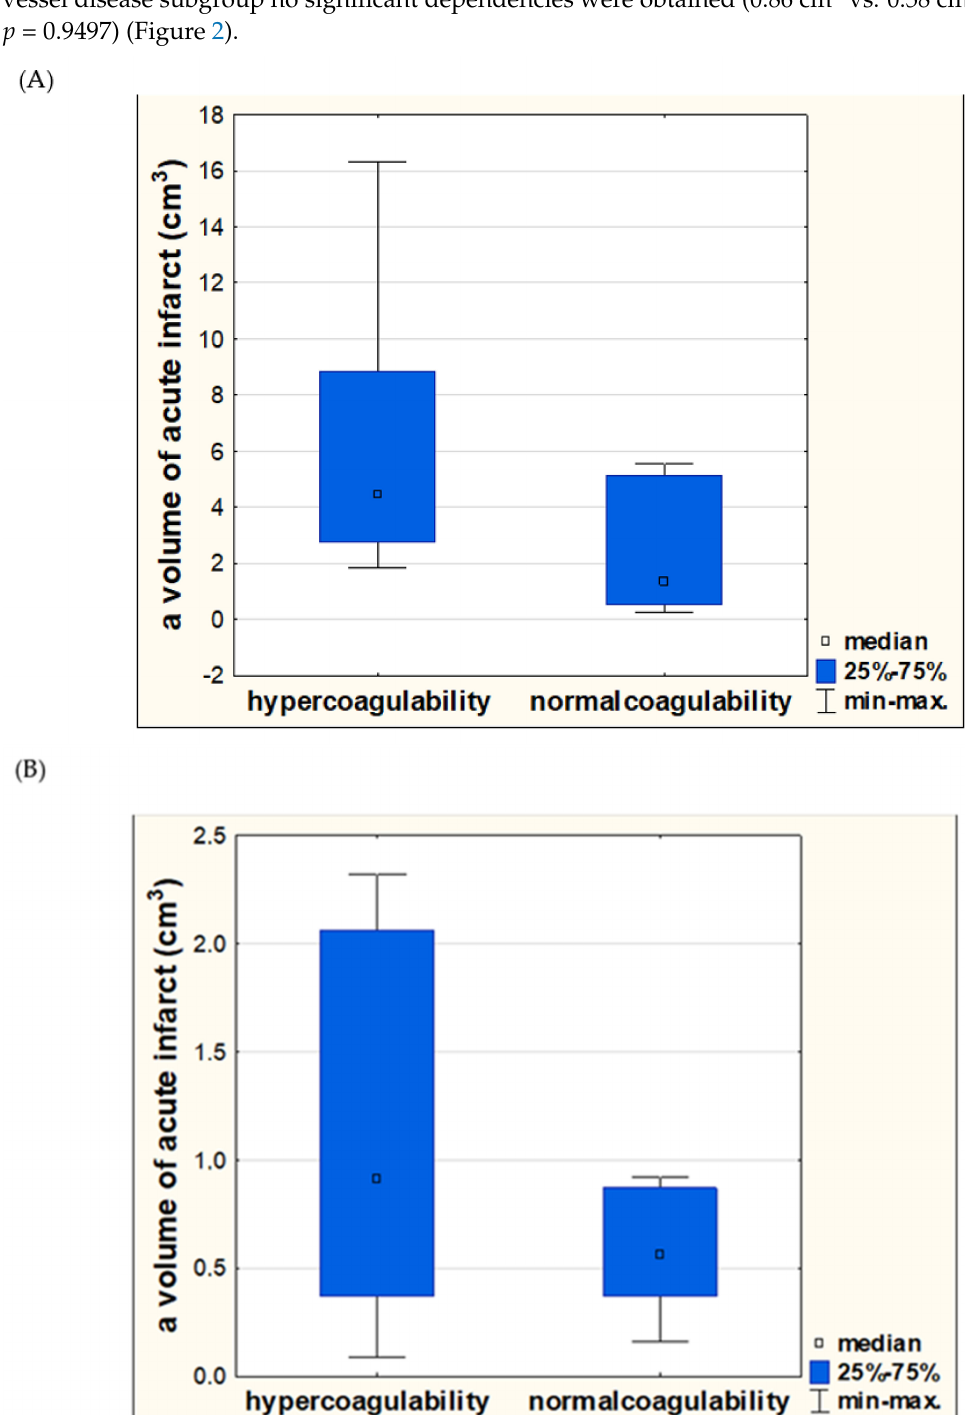
Figure 2. Differences in a volume of acute ischemic infarct (measured in cm 3 ) between stroke subjects with hyper- or normalcoagulability, distinguished by maximal amplitude in thrombelastography. Significant difference was reported only in a large artery atherosclerosis subgroup ( A ). No significant differences were noted in a small-vessel subgroup ( B